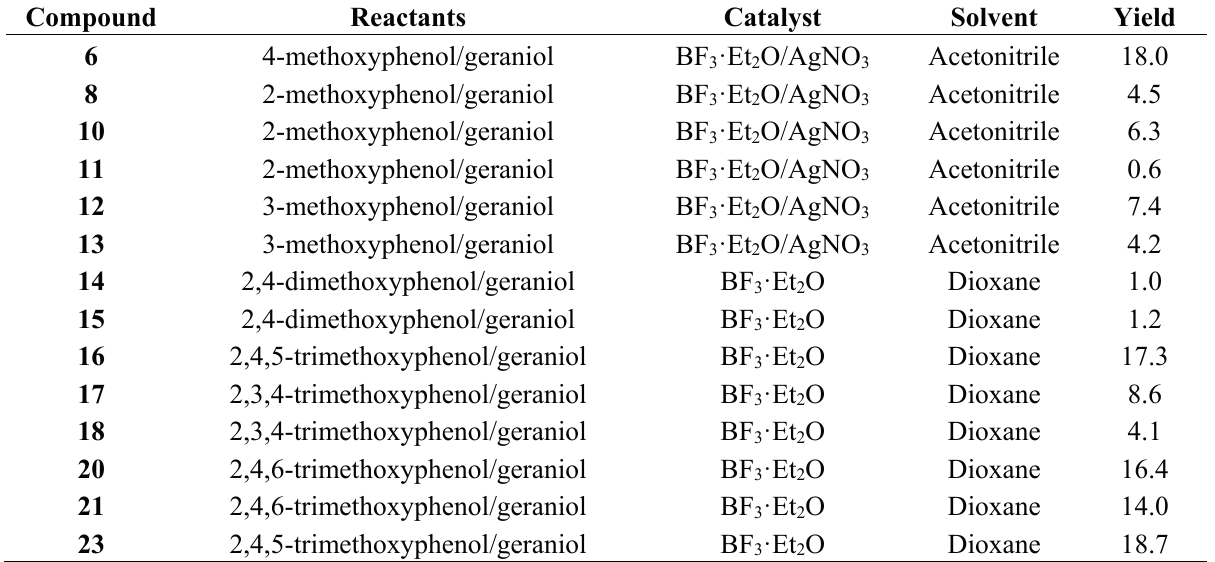
Table 1. Synthesis conditions and yield reactions of geranylated phenols and phenyl acetate